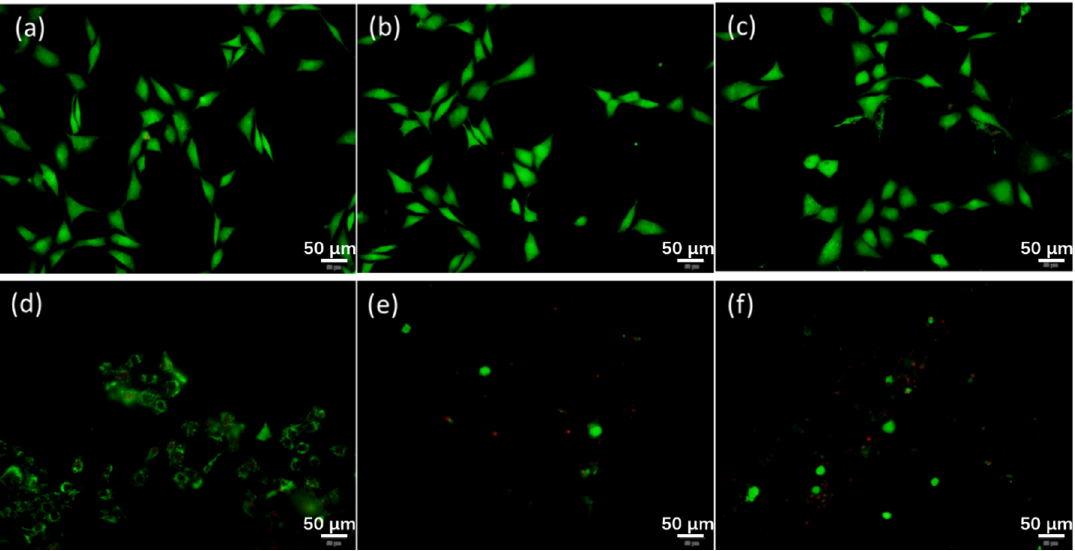
Figure 8. Confocal images of cells on VT, VT200, and VT400 before ( a – c respectively) and after ( d – f respectively) irradia- tion.